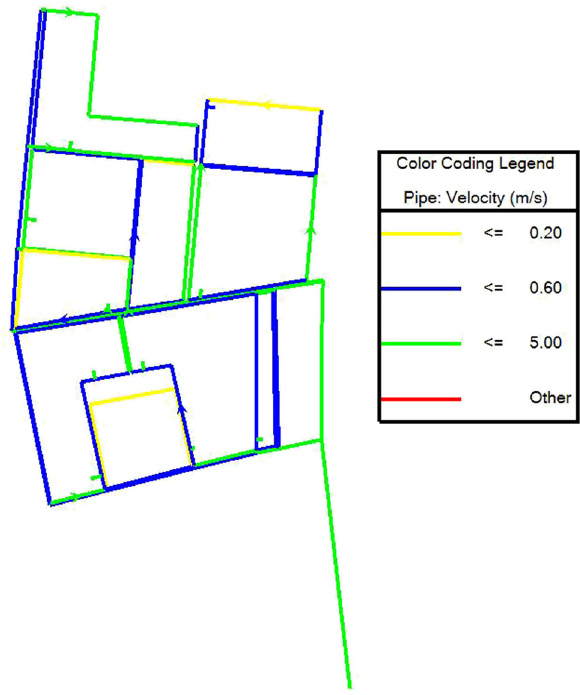
Figure 11: The ranges of velocities in the WDS at maximum water demand. Figure 12: The ranges of velocities in the WDS at low water